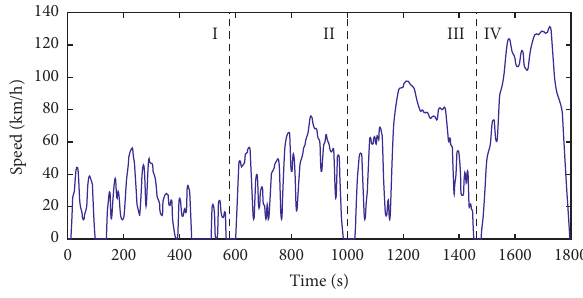
Figure 5: WLTC class 3 speed